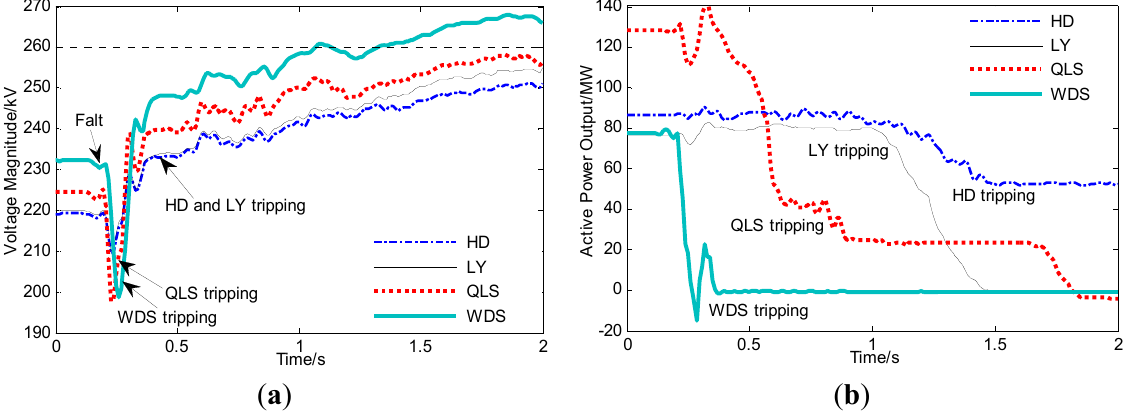
Figure 1. A cascading tripping incident involving centrally integrated wind farms in China: ( a ) voltage magnitudes of different wind farms; ( b ) active power outputs of different wind